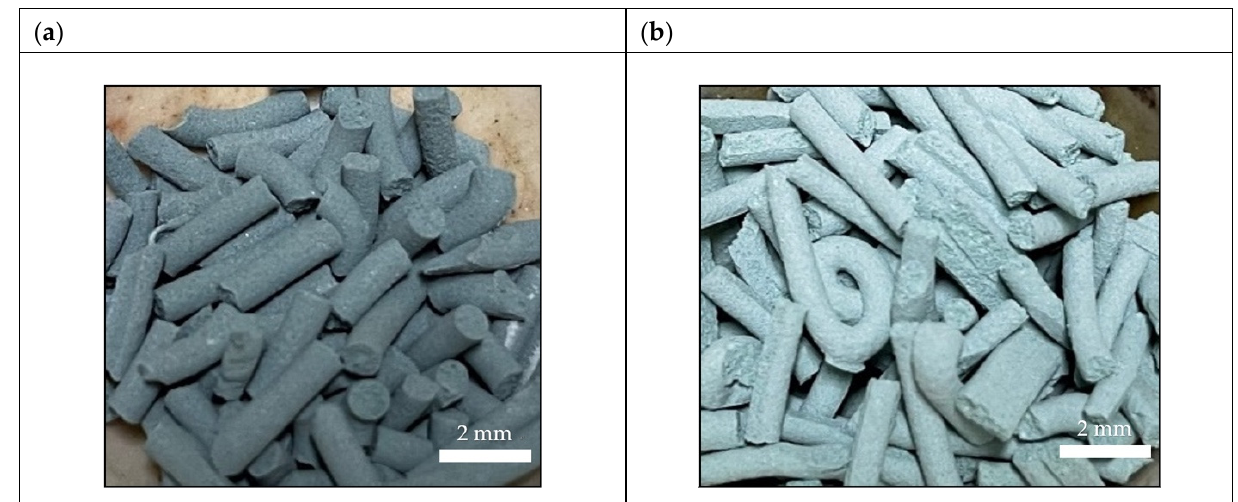
Figure 3. Images of the pellet-type Cu-based desulfurization sorbents shaped by the extrusion method, ( a ) CuO/ γ -Al 2 O 3 , ( b ) CuO/macro-porous Al 2 O 3